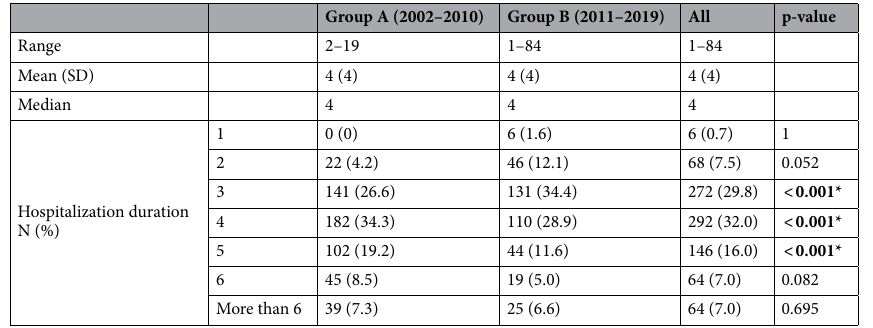
Table 2. Hospitalization duration (days) before and after (group A and B, respectively) inclusion of pediatric dental care in Israel’s National Health Insurance Law. *p-value < 0.05. Significant values are in